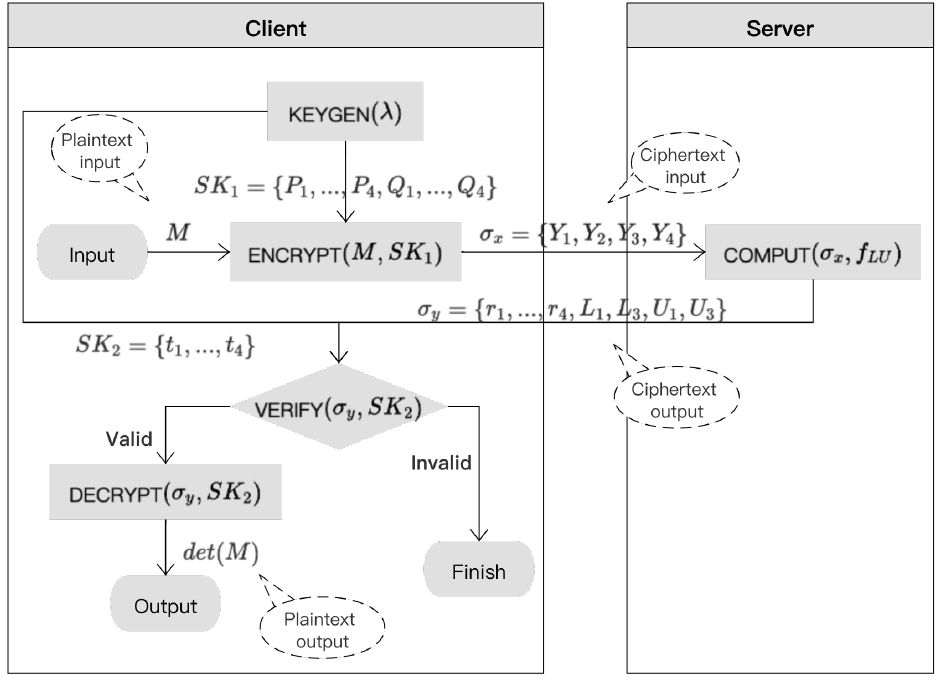
Figure 2. Flowchart of the secure outsourcing algorithm for matrix determinant